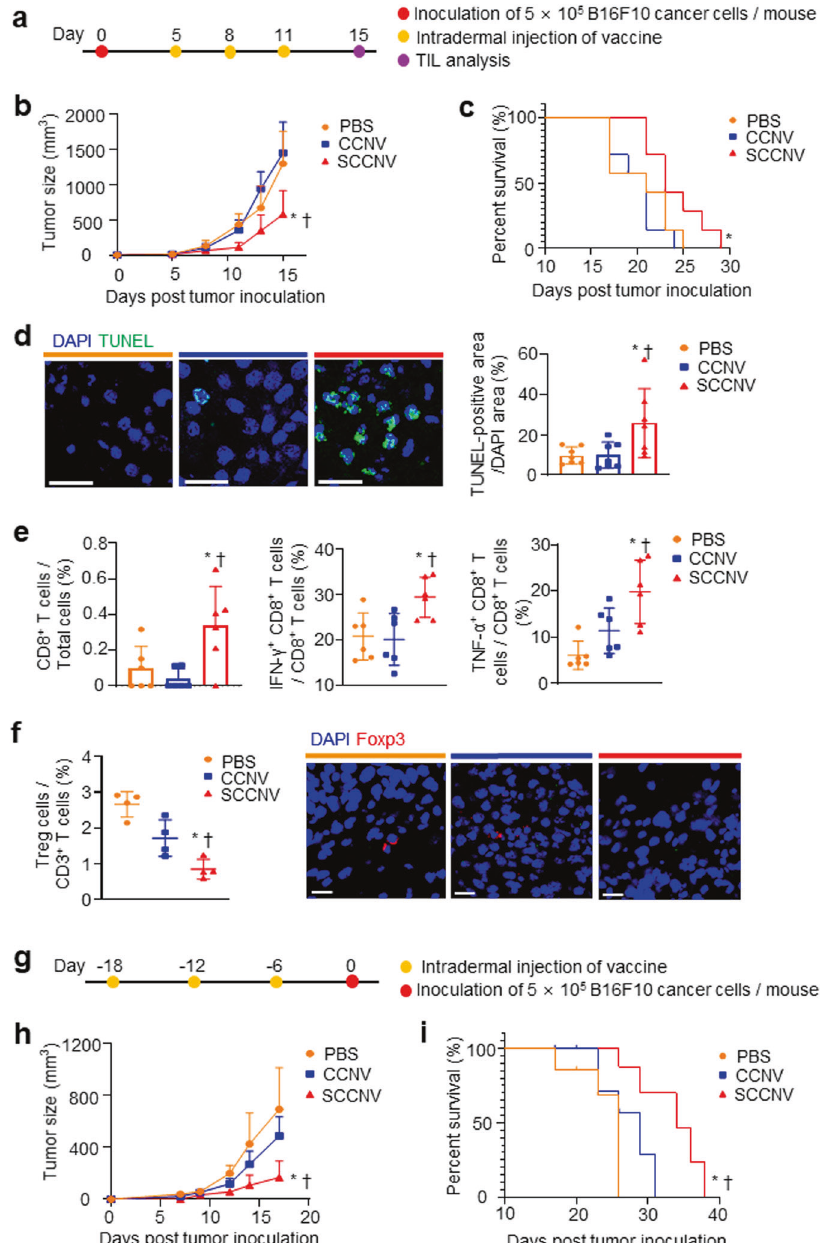
Fig. 6 Therapeutic ef fi cacy of SCCNVs in a therapeutic melanoma murine model and a prophylactic melanoma murine model. a Therapeutic tumor modeling and vaccination timeline for ( b – f ). b Tumor growth pro fi le. n = 6. c Animal survival rate. n = 6. d TUNEL staining of tumor tissues harvested on Day 15. n = 7. Scale bars = 100 μ m. e Immunohistochemical staining for CD8 + T cells in tumor tissues and fl ow cytometric TIL analysis of tumor tissues harvested on Day 15. n = 6. f Percentage of Treg cells measured in the fl ow cytometric TIL analysis ( n = 4) and immunohistochemical staining for Foxp3 in tumor tissues harvested on Day 15. Scale bars = 50 μ m. g Vaccination and prophylactic tumor modeling timeline for ( h ) and ( i ). h Tumor growth pro fi le. n = 5. i Animal survival rate. n = 5. Statistical signi fi cance was calculated by the log-rank (Mantel – Cox) test (c and i), one-way ANOVA with Tukey ’ s multiple comparisons test ( d – f ) or by two-way ANOVA with Bonferroni posttests ( b and h ). * P < 0.05 versus PBS; † P < 0.05 versus showed signi fi cantly higher densities of activated (IFN- γ - or TNF- α - SCCNVs were injected intradermally into B16F10 tumor-bearing positive) cytotoxic T cells in the SCCNV-immunized group (Fig. 6e; mice (Fig. 6a). SCCNVs signi fi cantly suppressed tumor growth Supplementary Fig. 9 and 10). Moreover, TIL analysis and IHC in vivo and improved animal survival (Fig. 6b, c; Supplementary staining showed that the regulatory T-cell density was signi fi cantly Fig. 8). A terminal deoxynucleotidyl transferase dUTP nick end lower in the SCCNV-immunized group, indicating a proin fl amma- labeling (TUNEL) staining assay showed a signi fi cantly higher tory microenvironment in the SCCNV-immunized group (Fig. 6f). density of apoptotic cells in tumor tissues in the SCCNV- Furthermore, in the prophylactic model, mice that underwent immunized group (Fig. 6d). Immunohistochemical (IHC) staining immunization were challenged with B16F10 melanoma cells (Fig. and tumor-in fi ltrating lymphocyte (TIL) analysis of tumor tissues